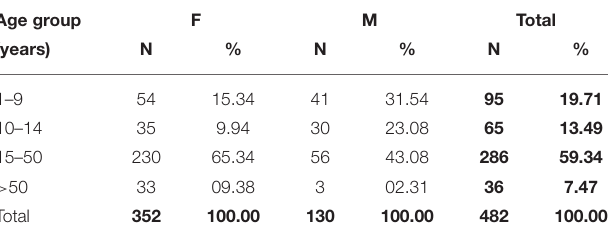
TABLE 1 | Absolute and percentage distribution of the total sample by age group and gender.